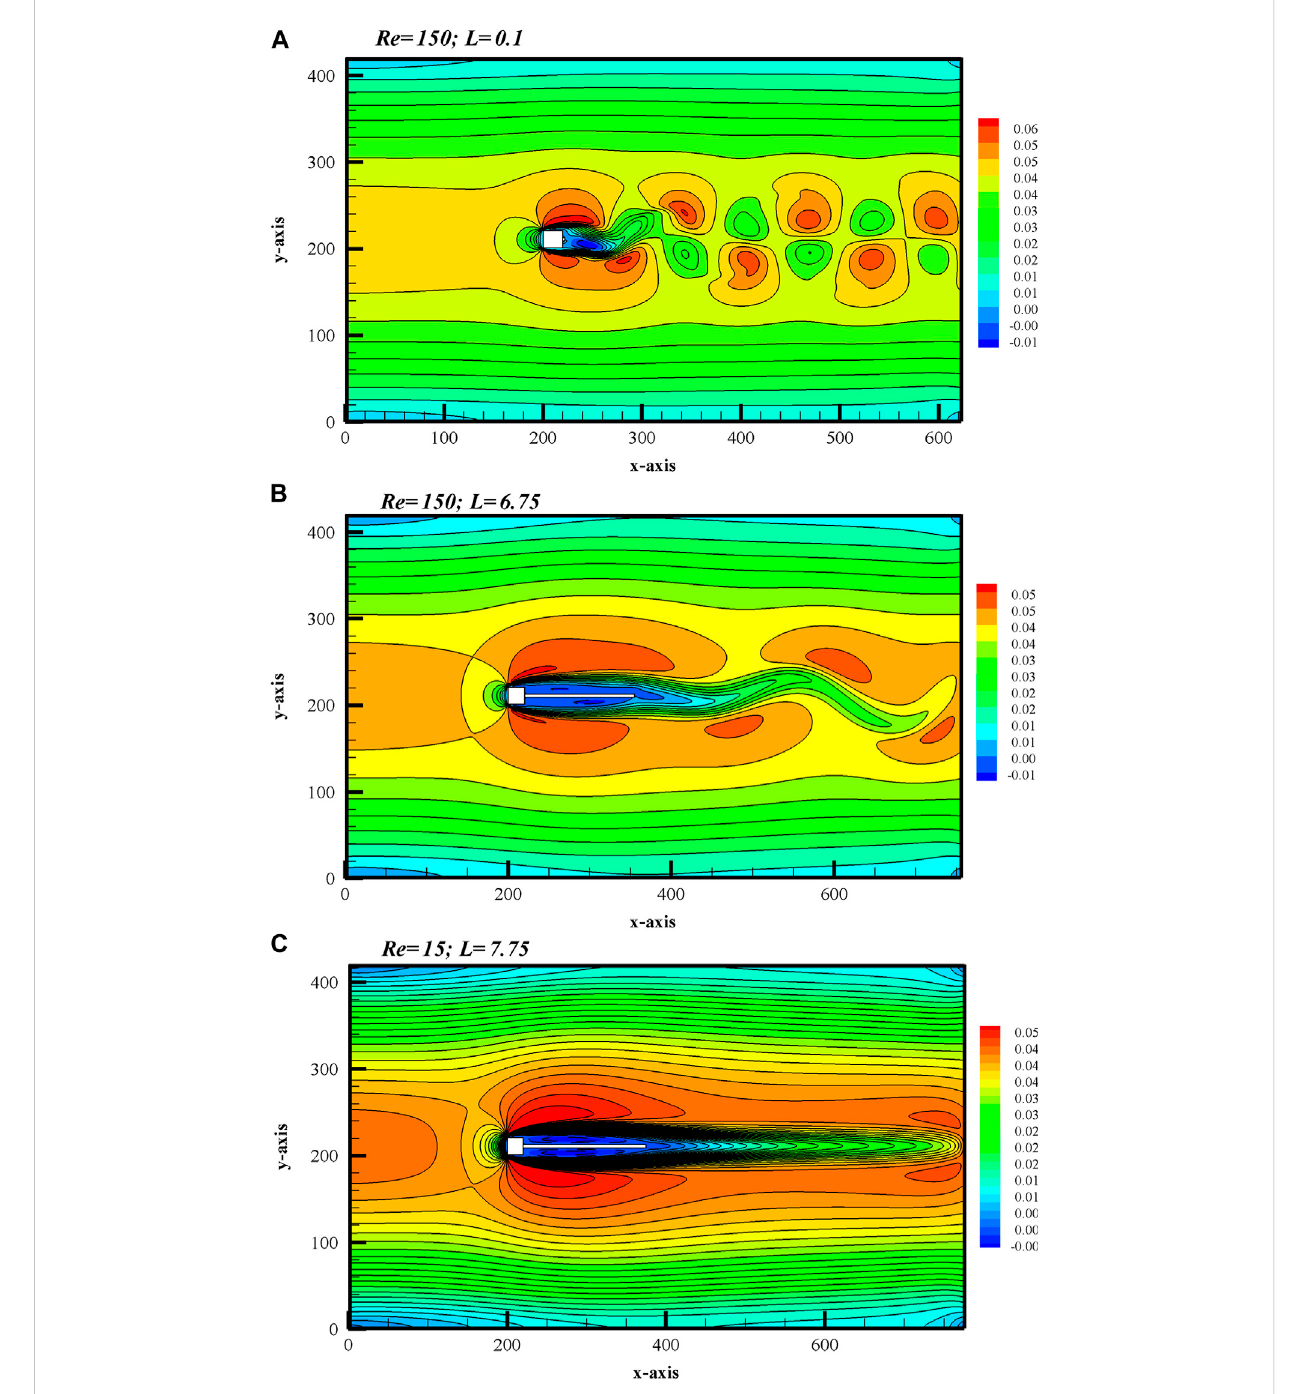
FIGURE 11 Velocity contours for (A) unsteady, (B) transient, and (C) steady fl ow